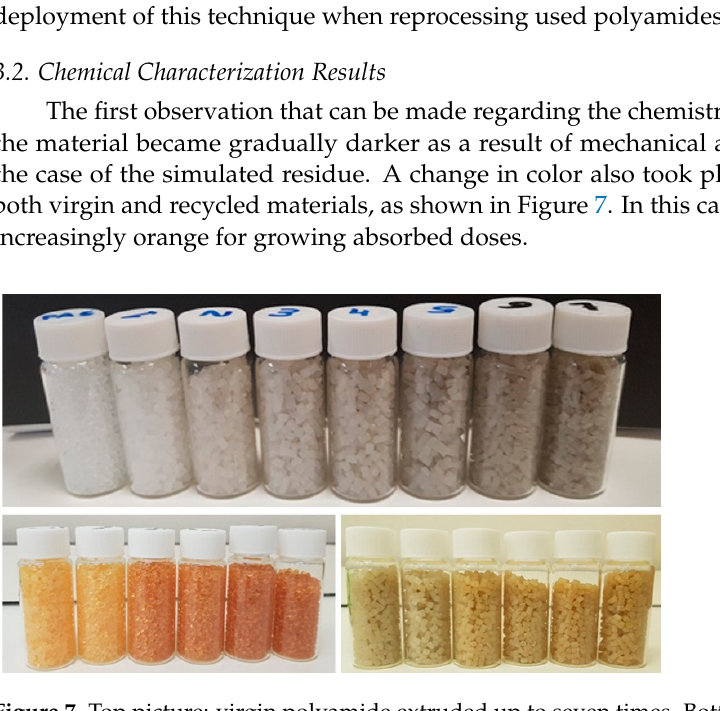
Figure 7. Top picture: virgin polyamide extruded up to seven times. Bottom left: irradiated virgin PA-6. Bottom right: Irradiated recycled PA-6.